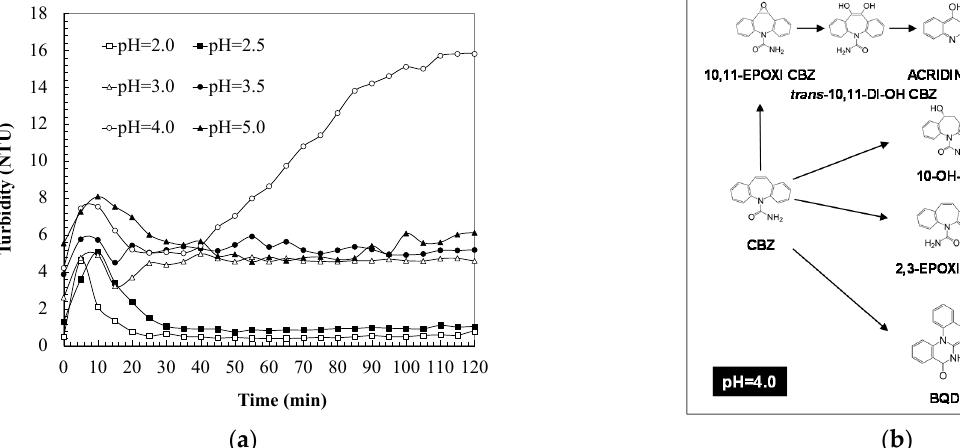
Figure 2. ( a ) pH effect on turbidity changes in a photo-Fenton system during the carbamazepine oxidation. ( b ) Equilibrium-species in carbamazepine aqueous solutions oxidized at pH = 4.0 by photo-Fenton treatment. Experimental conditions: (CBZ) = 50.0 mg/L; (H 2 O 2 ) = 15.0 mM; (Fe) = 10.0 mg/L; (UV) = 150 W; T = 40 °C.